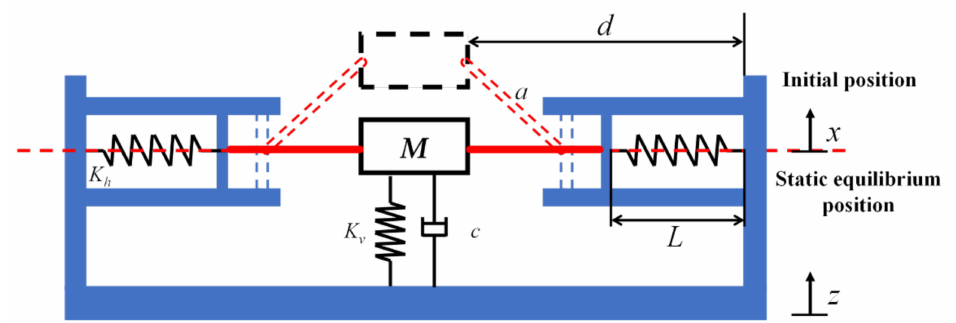
Figure 2. The model of the quasi-zero stiffness passive vibration control